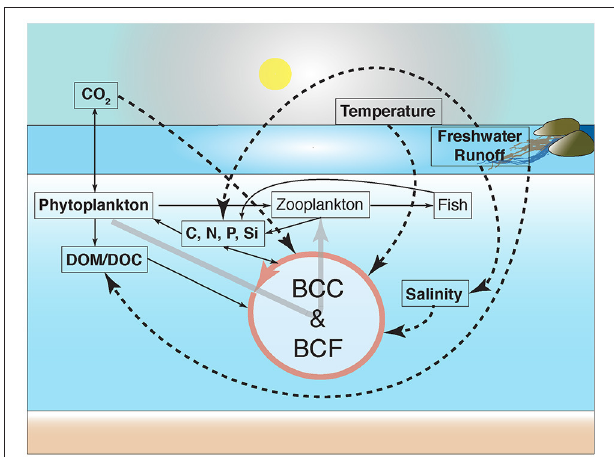
FIGURE 2 | Causal-loop diagram indicating potential ecosystem-wide effects in carbon cycling due to responses among bacterioplankton populations to natural and anthropogenic disturbances. Bacterioplankton community composition and functioning have been abbreviated to BCC and BCF, respectively. The figure is redrawn and modified from (Azam and Malfatti, 2007). Continuous and dashed arrows denote nutrient fluxes and changes in environmental variables with empirical evidence of significant effects on bacterioplankton community composition covered in this review, respectively. Changes in bacterioplankton community functioning, such as bacterial heterotrophic production and respiration, may occur due to increases in the availability of dissolved organic matter (DOM), resulting from, for example, increased freshwater runoff and phytoplankton